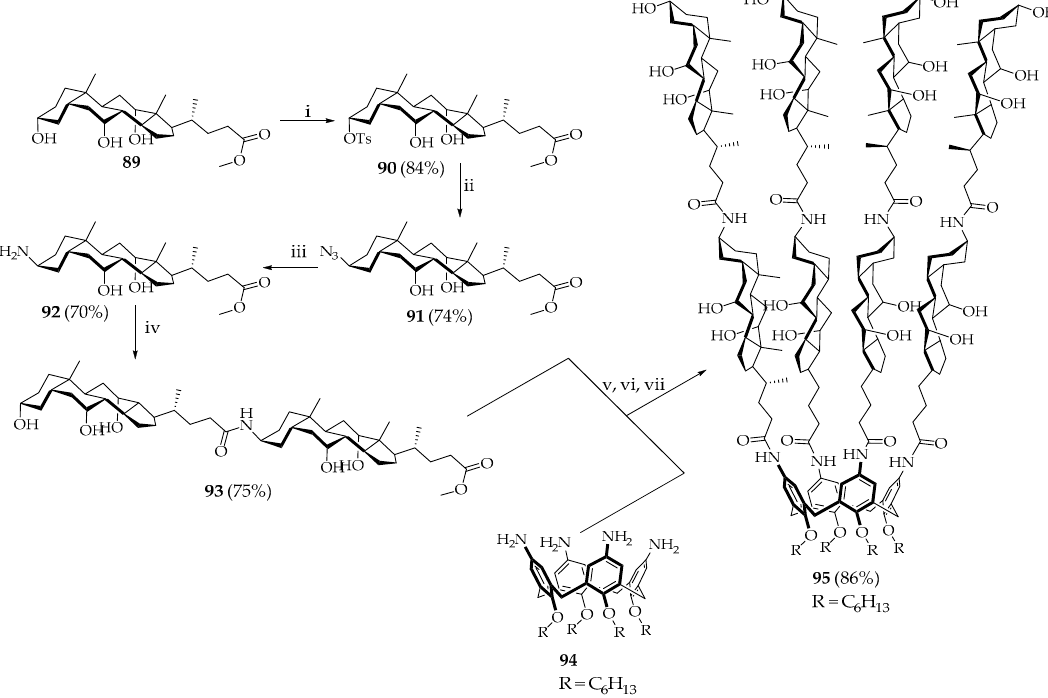
Figure 11. Structures of macrocycles 99 - 100 .